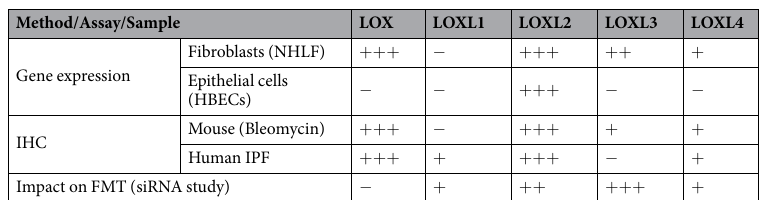
Table 2. Summary of LOX/L expression changes under fibrotic conditions and impact on FMT based on the results of this